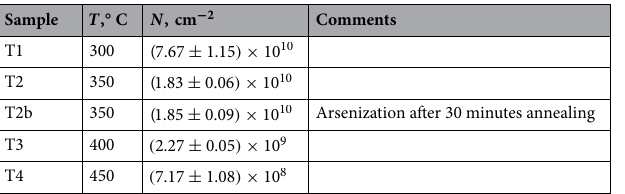
Table 1. The substrate temperature during the Ga droplet nucleation and the subsequent arsenization of the samples, presented in this work as well as the GaAs island density of the samples.